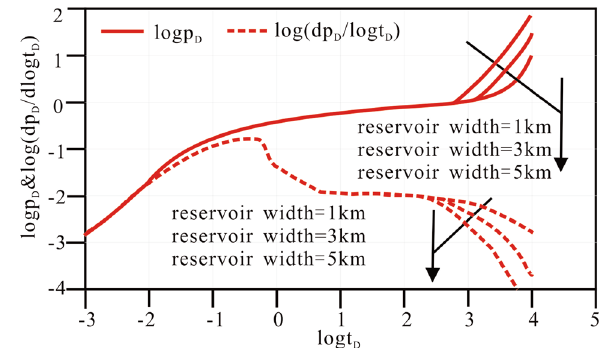
Fig. 10 The effect of reservoir anisotropy on template curves